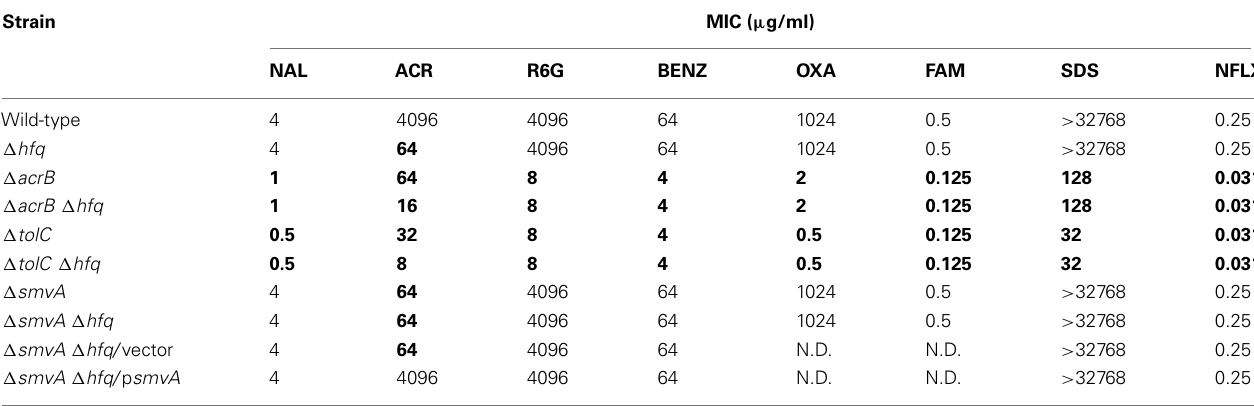
Table 2 | Susceptibility of Salmonella strains to toxic compounds.